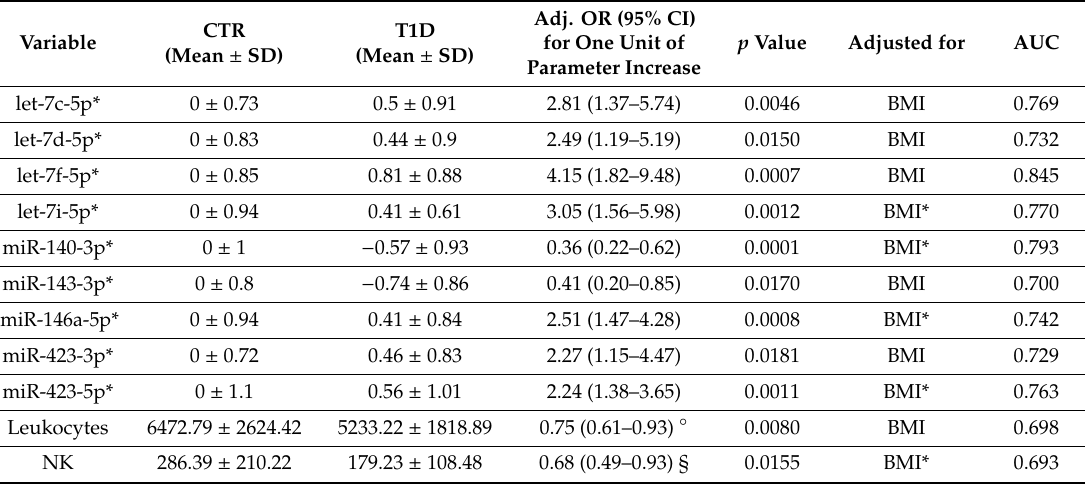
Table 2. Association of miRNAs and immune cells with T1D disease status at diagnosis. Multivariate logistic models, adjusted for body mass index (BMI), were evaluated for plasmatic miRNAs, expressed as log2 fold change in T1D compared to CTR children, and peripheral blood circulating immune cells, expressed as absolute number / mm 3 of blood. Legend: NK, natural killer; OR, odds ratio; CI, confidence